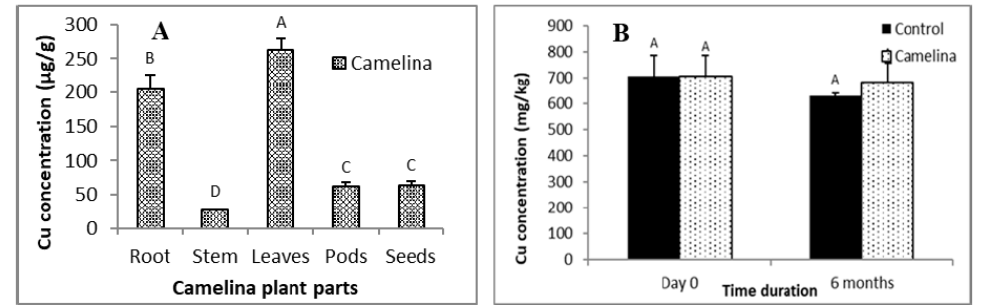
Figure 4. Cu (µg/g) in different parts of camelina plants during the study period ( A ). Cu (mg/kg) in stamp sand in control (no plant) and camelina panels during the study period ( B ). Data are reported as mean ± S.D ( n = 3). Means are compared by Tukey Kramer-HSD test ( α = 0.05). The treatment levels that are not connected by the same letter are significantly different from each other.